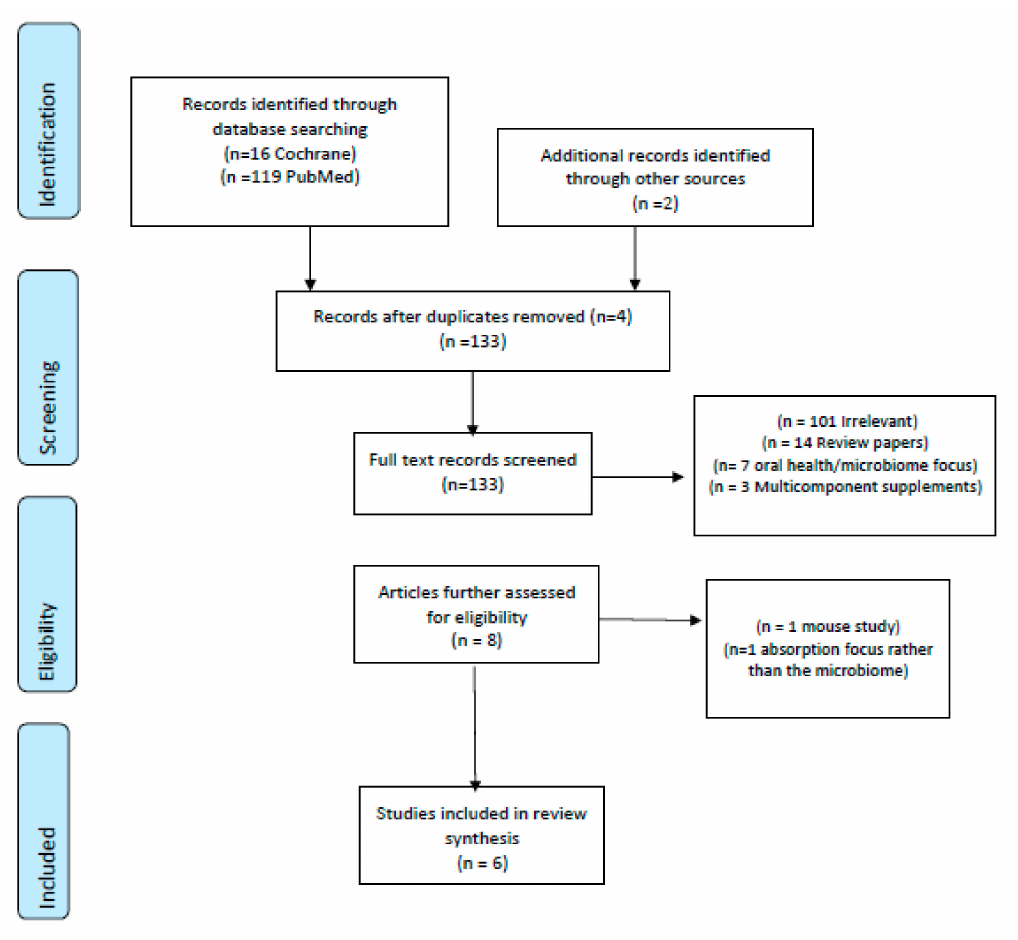
Figure 1. PRISMA algorithm used to identify trials